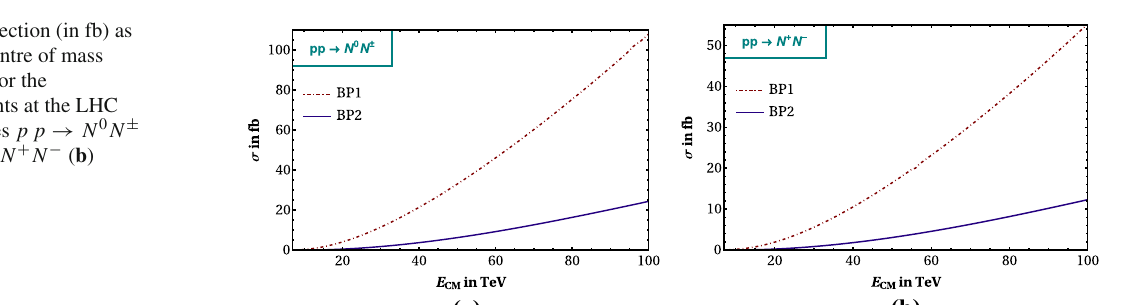
Fig. 5 Cross-section (in fb) as a function of centre of mass energy ( E CM ) for the benchmark points at the LHC for the processes p p → N 0 N ±